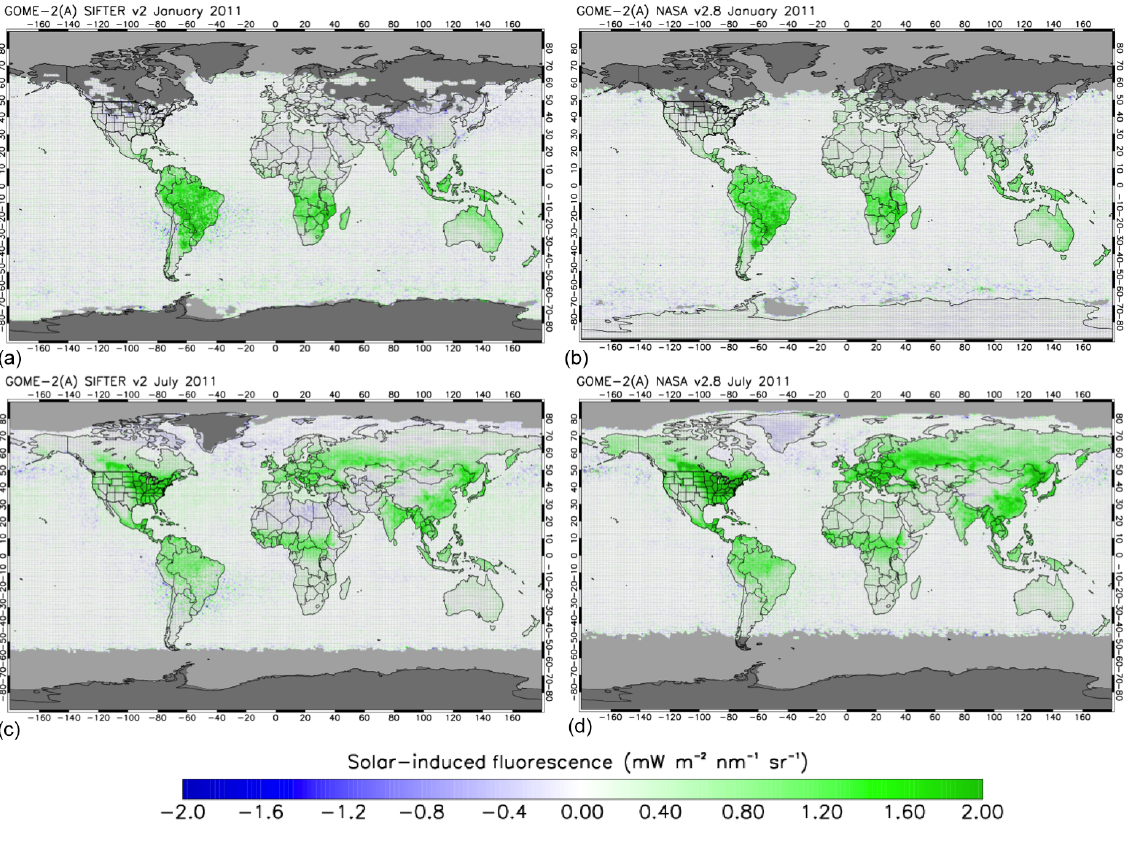
Figure 9. Gridded monthly mean SIF values retrieved from GOME-2A with SIFTER v2 (a, c) and NASA v2.8 (b, d) in January and July 2011. SIFTER data have been selected for autocorrelation < 0 . 2 and cloud fraction < 0 . 4, and NASA v2.8 data have been selected for cloud fraction < 0 . 3.